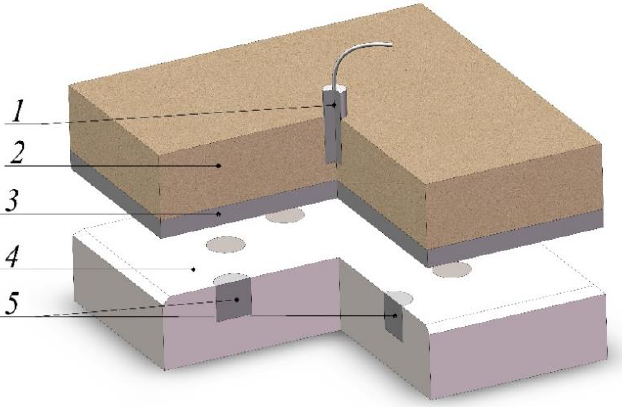
Figure 5. Schematic of testing under shock-wave loading: 1 — detonator, 2 — explosive, 3 — flyer plate (steel), 4 — matrix, nd 5 — specimens.